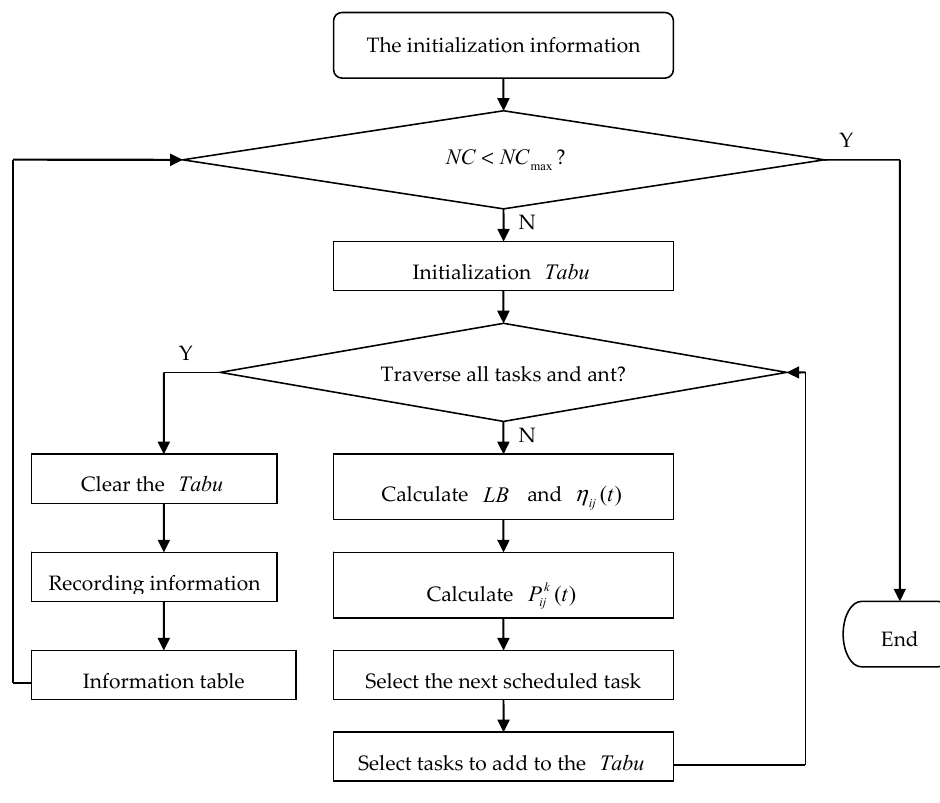
Figure 2. The flow chart of the ant colony optimization task scheduling algorithm based on load balancing.